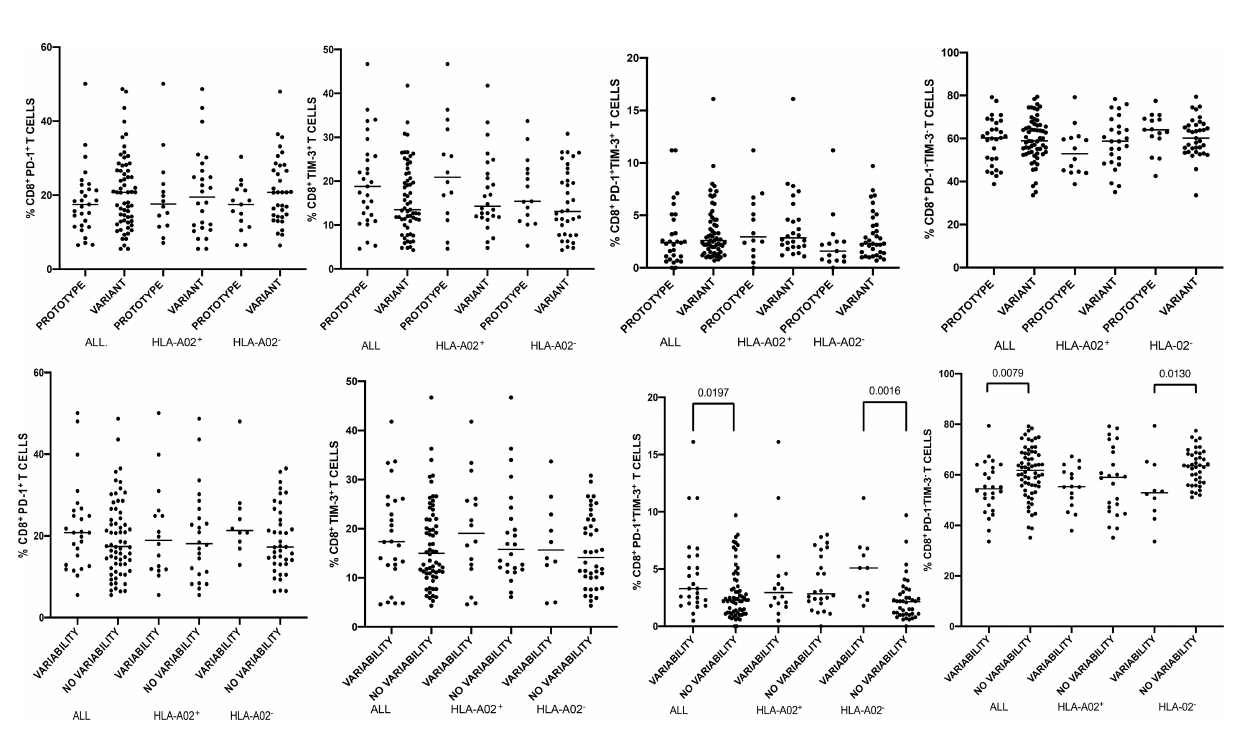
FIGURE 3 | Percentages of peripheral blood CD8 + T-cells expressing PD-1/Tim-3 in patients infected with either NS3 1406 prototype (GenBank EU255962.1) or variant epitope sequence as the dominant strain (upper panel). Lower panel shows intrahost aminoacid variability of this epitope where no variability denotes the presence of a single variant and variability indicates ≥ 2 variant sequences. Horizontal lines represent median values. Numbers above each bracket express P